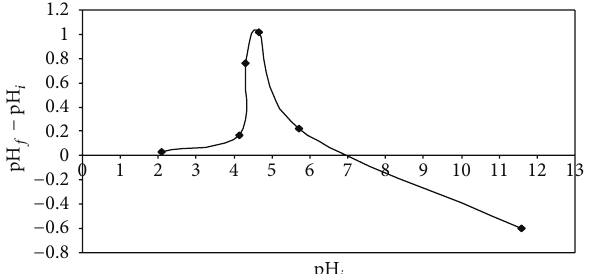
Figure 5: Determination of the point of zero charge of IJSP.